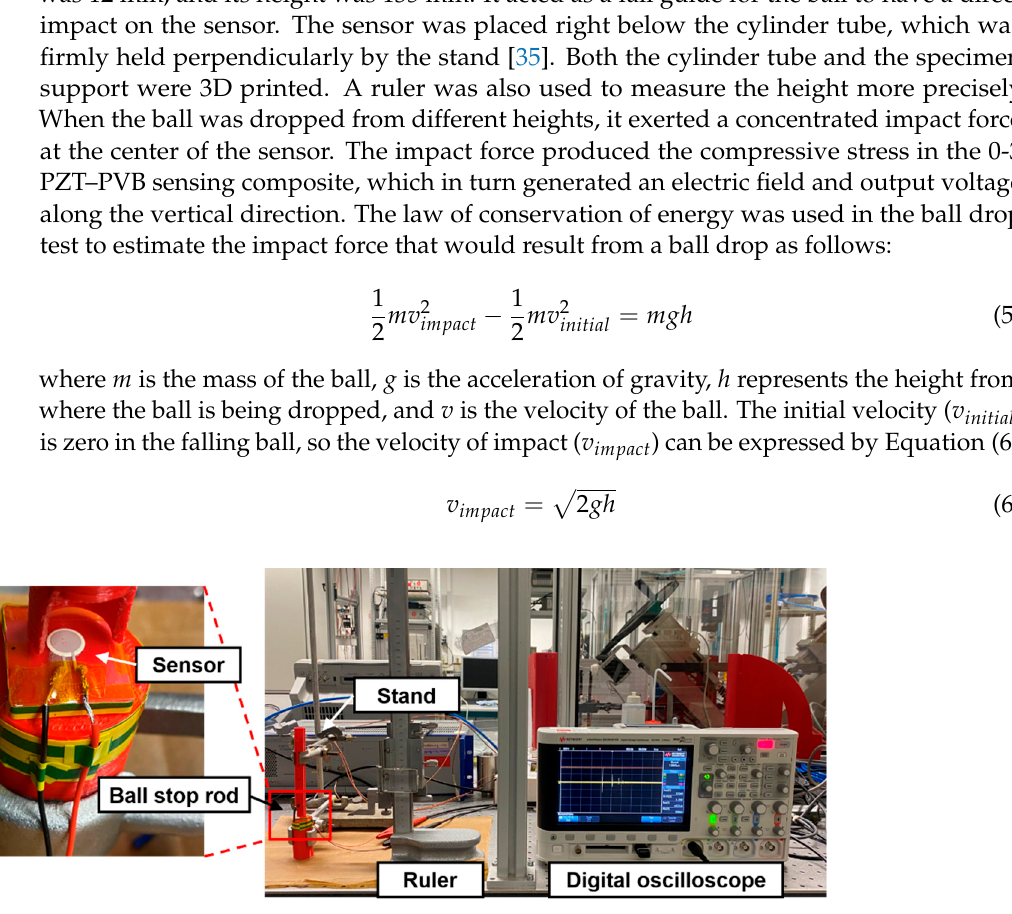
Figure 7. Ball drop test experimental setup for measuring the response of the PZT–PVB composite to impact force.